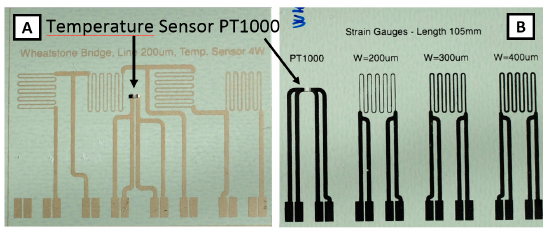
Figure 2. Fabricated samples of Wheatstone bridge-based strain sensor with sensitive and compensating resistors and temperature sensor ( A ). Single element piezoresistors (for four-point measurement) with different line width ( B ).